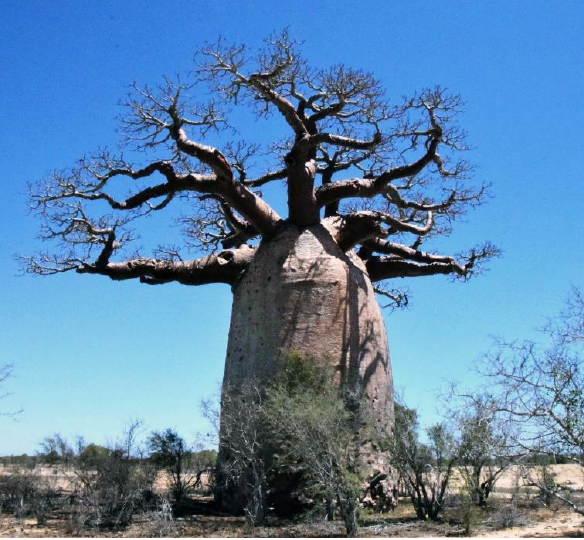
Figure 7. Photo of A 215 showing its southwestern side, which has a bell jar shape. The horizontal dimensions of the canopy are 22.8 (WE) × 16.7 m (NS).